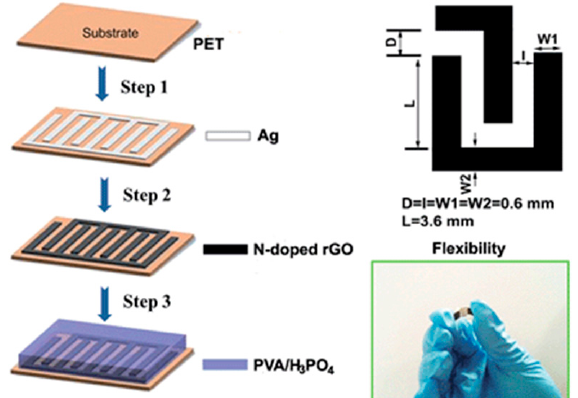
Figure 8. Schematic illustration for the fabrication of flexible solid-state micro-supercapacitor utilizing screen printing. Reproduced with permission from Reference [121]. Copyright © 2014 The Royal Society of Chemistry.